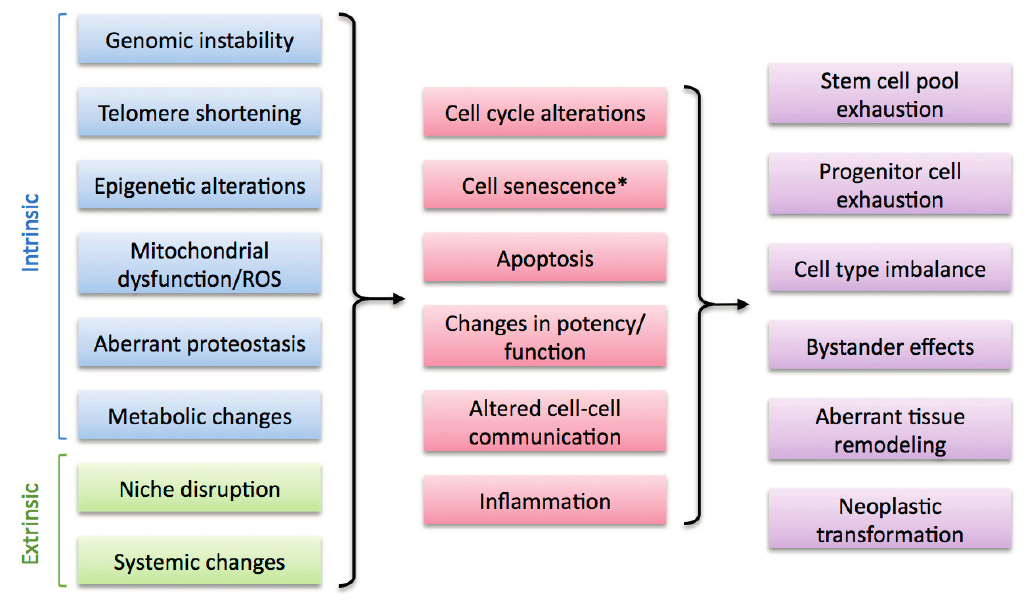
Figure 3. Factors that alter regenerative capacity upon aging. Multiple cell-intrinsic and cell-extrinsic factors are associated with the decline of regenerative capacity during aging ( left ). These impact on regenerative cell types by altering key cellular processes ( middle ), leading to various negative outcomes that result in regeneration impairment ( right ). * Cell senescence can be considered an intrinsic and, potentially, extrinsic factor (see Section